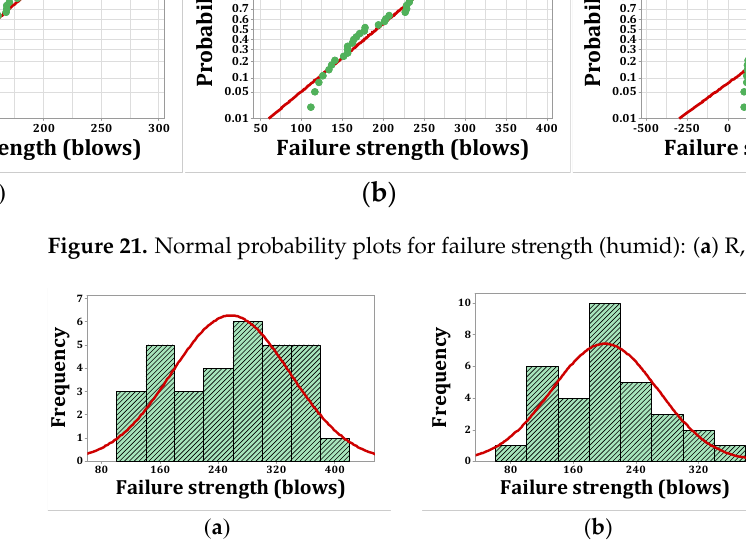
Figure 22. Distribution plots for failure strength (humid): ( a ) F5, ( b ) F2F3.